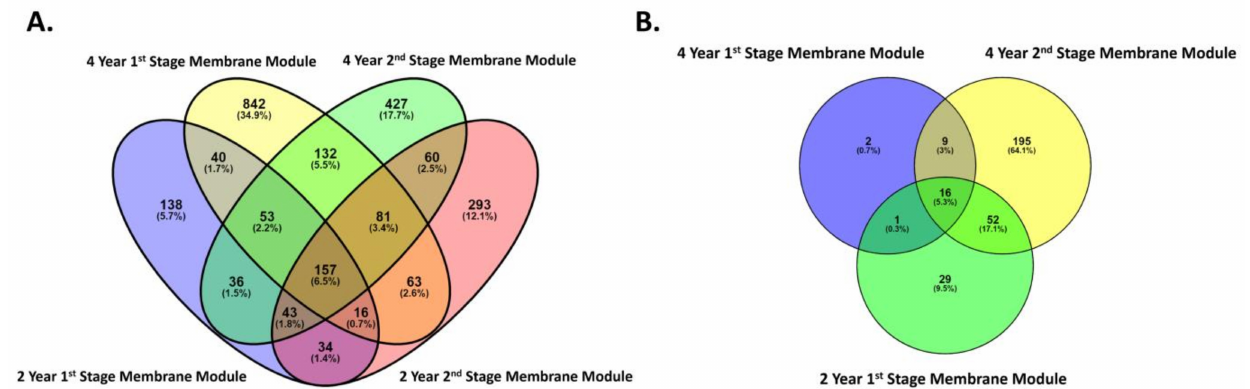
Figure 7. Venn diagram displaying the overlap between the ( A ) prokaryotic communities in the 2- and 4-membranes in the 1st and 2nd stage positions and ( B ) eukaryotic communities in the 2- and 4-membranes modules in the 1st and 2nd stage positions. Core OTUs, identified in all sampling sites; variable OTUs, identified in two or more sites but not all; unique OTUs, identified in only one